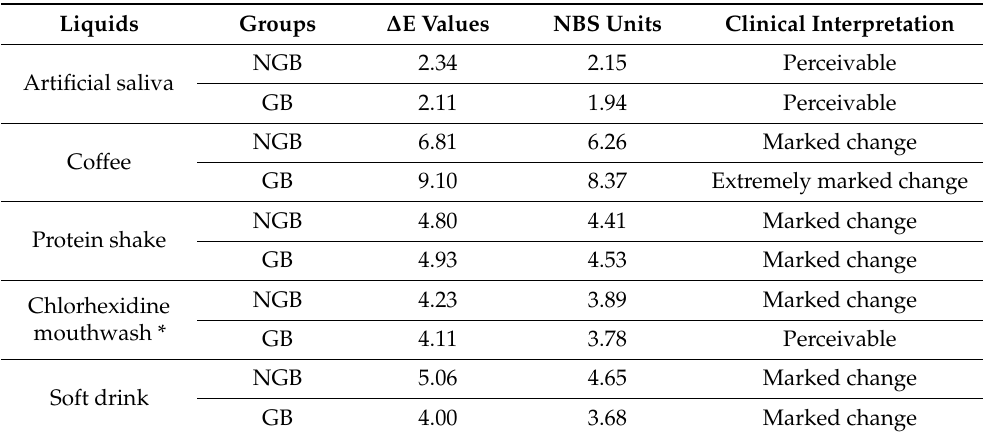
Table 8. Color change in extra translucent group after 28